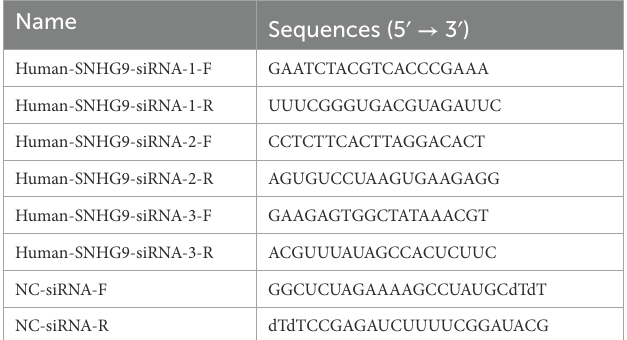
TABLE 1 Long noncoding RNAs (lncRNAs) SNHG9 siRNA